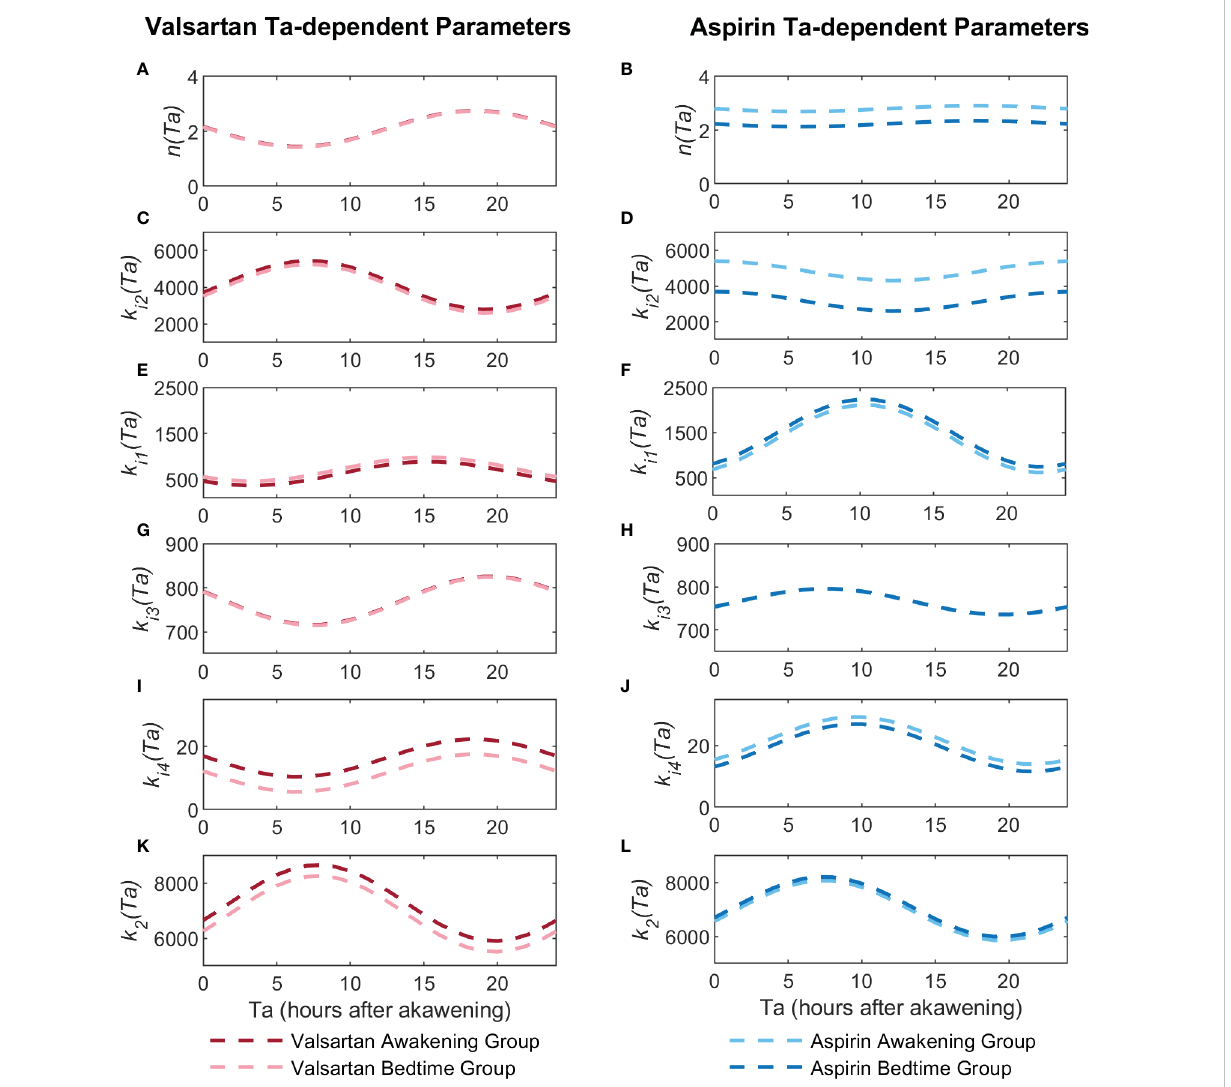
FIGURE 3 Ta-dependent parameter pro fi les (p(Ta)) for the valsartan and aspirin models. Figures (A, C, E, G, I, K) show the parameter pro fi les of the n , k i 2 , k i 1 , k i k k i 3 , 4 and 2 for valsartan, respectively. Figures (B, D, F, H, J, L) show the parameter pro